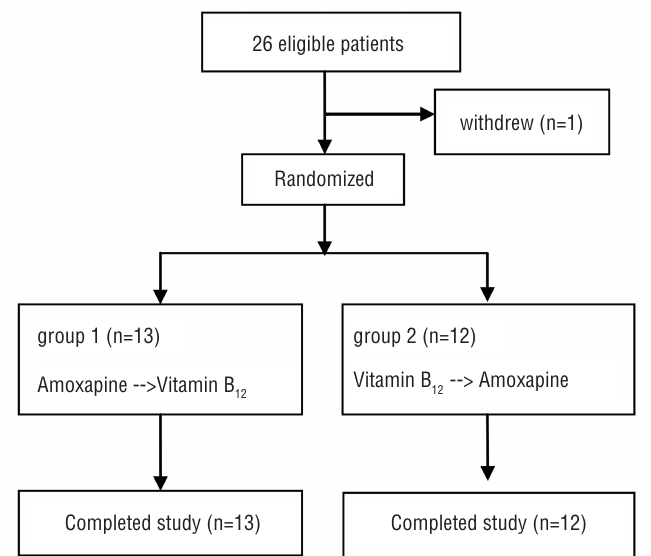
figure 2 - Enrollment and follow up of study subject.